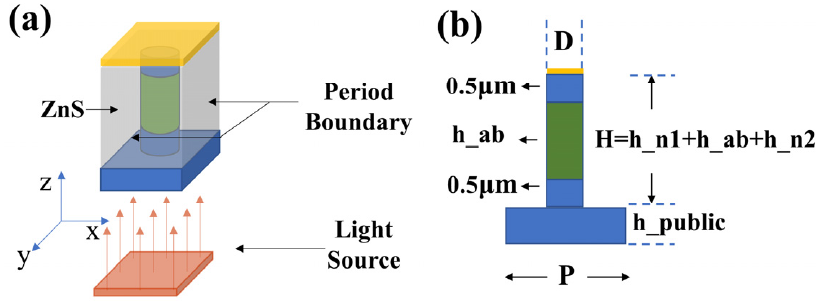
Figure 5. Geometric structures of ( a ) periodic unit and ( b ) XZ cross-section of the periodic unit. After precise scanning of the parameters, the maximum quantum efficiency of 80% at 10.5 μ m occurs at h_ab = 1.705 μ m and h_ public = 1.65 μ m, as shown in Figure 6a,b. In order to obtain the reasons for the high quantum efficiency at 10.5 μ m, we have analyzed |E x | distribution in XZ cross-sections of the device at several points in Figure 6b. As shown in Figure 6c, in the air region, the nonuniformity of |Ex| distribution near the interface 1 arises from the leakage of the mode excited by the grating; the bright and dark distribution of the far-field mainly stems from the interference between the incident light and the light reflected at the interface 1. In increasing h_ab, the interference effect in the air region becomes weaker and then stronger. When h_ab is equal to 1705 nm, the interference effect almost disappeared, indicating almost no light reflection at interface 1. This phenomenon suggests that the device may work as an antireflective film. The best antireflection effect occurs at L = λ [27,28], where λ is the wavelength, and L and n are the film’s thickness and effective refractive index, respectively. Before the increase in h_ab to 1705 nm, the device has an excellent energy limiting effect. It suggests that the peak quantum efficiency of 80% arises from the device with h_ab = 1705 nm working as an FP cavity in the z-direction. During the increase of h_ab from 1705 nm to 2098 nm, the mode leakage becomes more severe. As the cavity length changes from the optimal value, the energy localization condition is increasingly unsatisfied, decreasing the quantum efficiency.